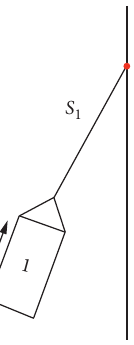
Figure 6: Definition and calculation of conflicts between the vehicle and the road facility.